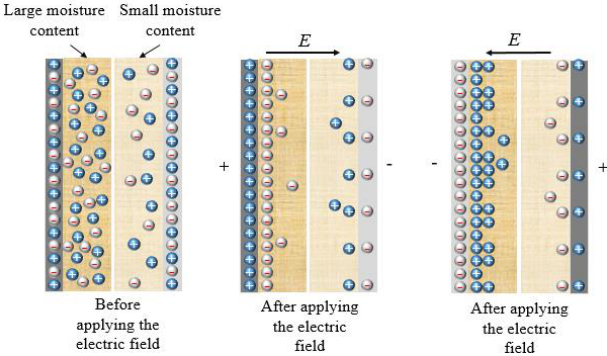
Figure 19. Ion distribution when moisture is non-uniform under AC electric field .